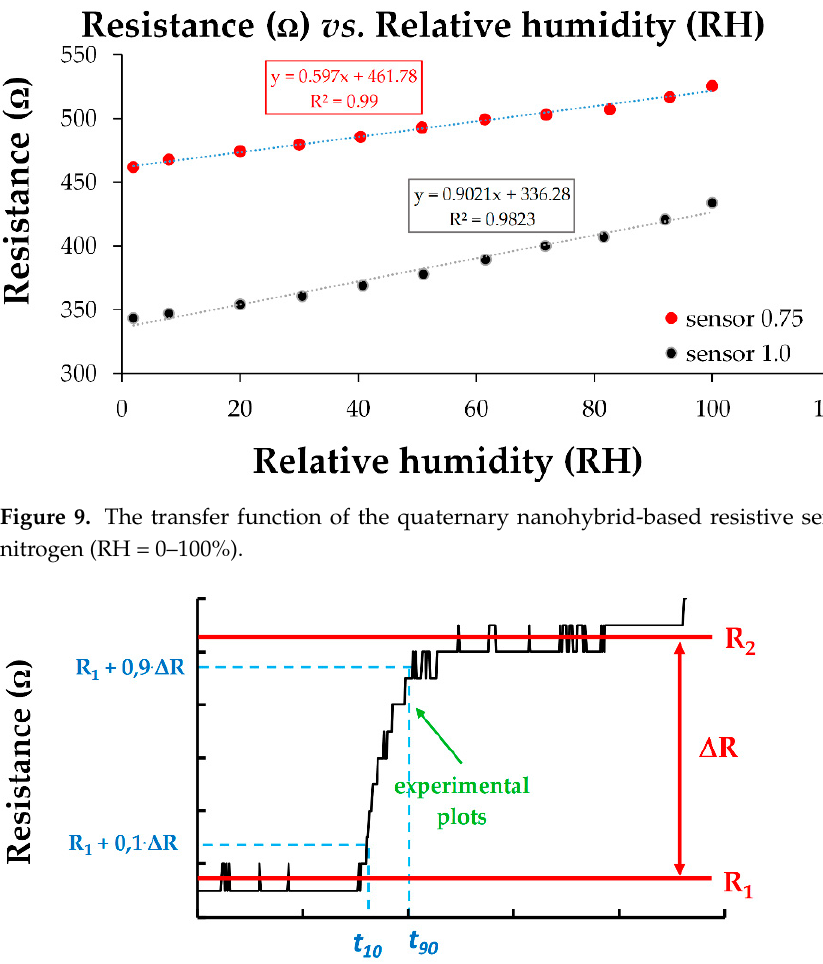
Figure 9. The transfer function of the quaternary nanohybrid-based resistive sensors in humid nitrogen (RH = 0–100%).